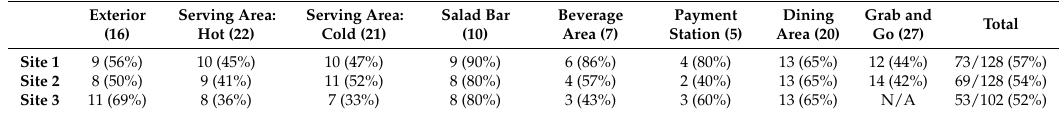
Table 4. NudgeSAT results for each area of the cafeteria environment from all